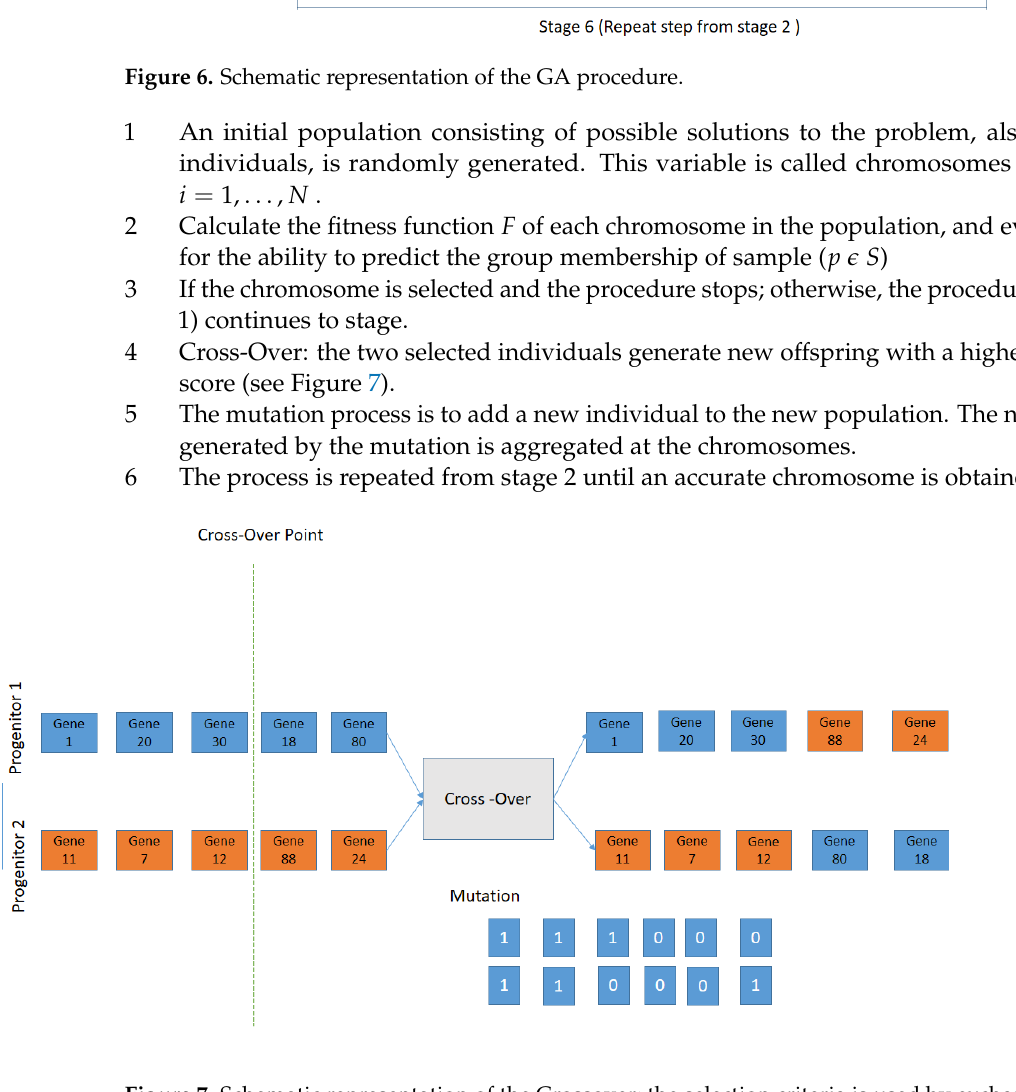
Figure 7. Schematic representation of the Crossover; the selection criteria is used by exchanging the genes of parents from one generation to the